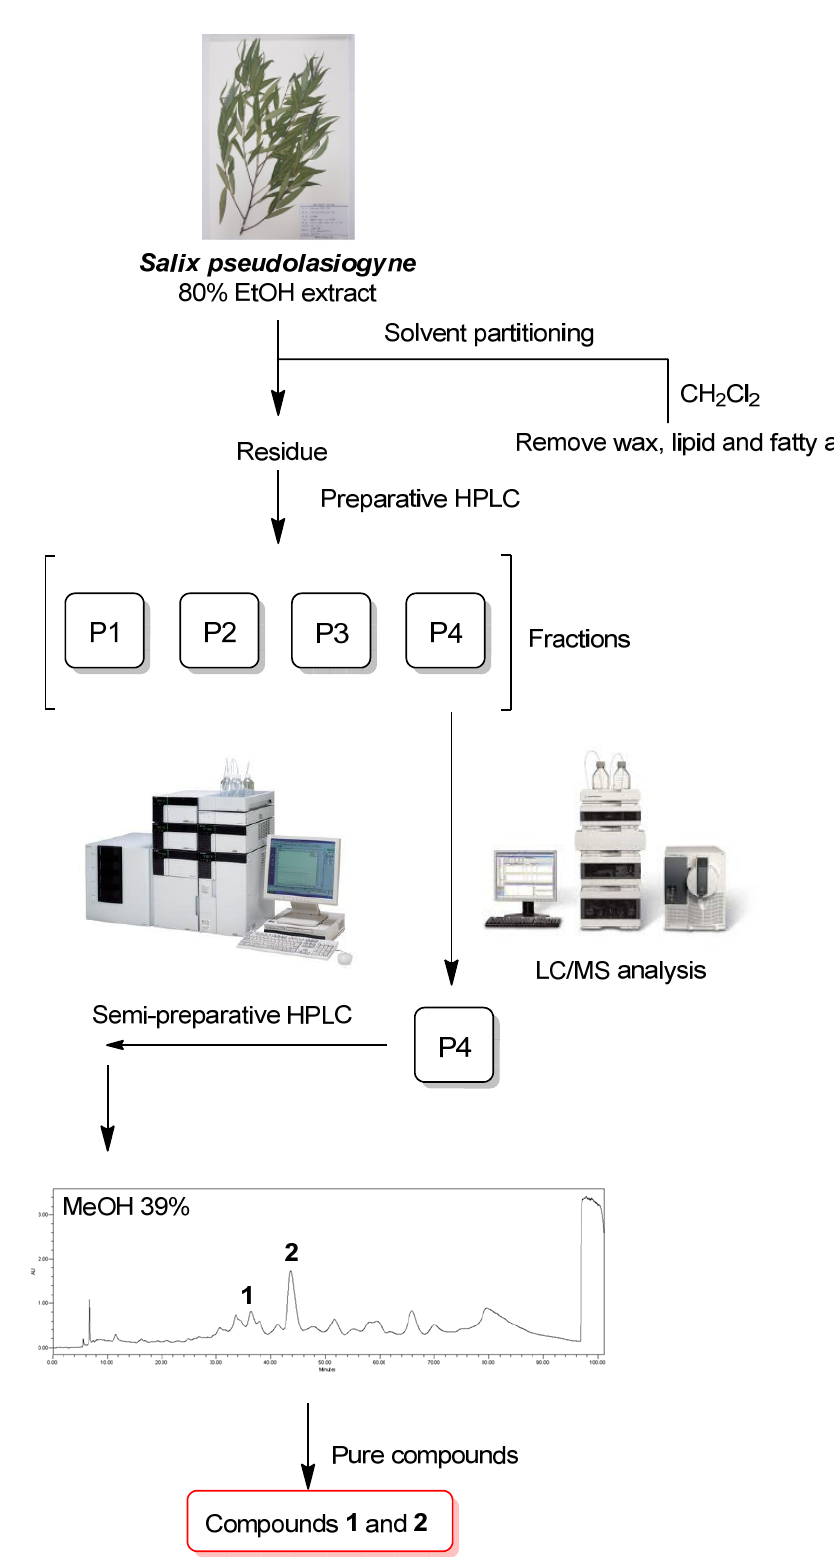
Figure 1. Schematic representation of oregonin ( 1 ) and 2 ′ - O -acetylsalicortin ( 2 ) isolation.